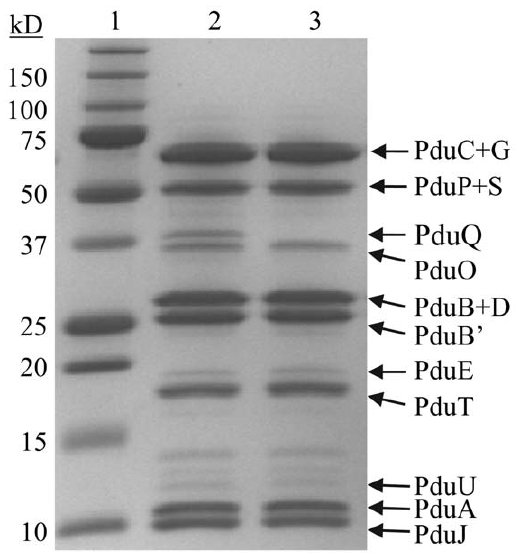
Figure 2. PduQ is a component of the Pdu MCP. Panel A: 10–20% SDS-PAGE gel stained with Bio-Safe Coomassie. Lane 1, molecular mass markers; lane 2, 10 m g Pdu MCPs purified from wild-type Salmonella ; lane 3, 10 m g Pdu MCPs purified from a pduQ deletion mutant BE903. Panel B: Western blot with antisera against PduQ peptide (51–64). Lane 1, 10 m g Pdu MCPs purified from wild-type Salmonella ; lane 2, 10 m g Pdu MCPs purified from D pduQ mutant BE903.